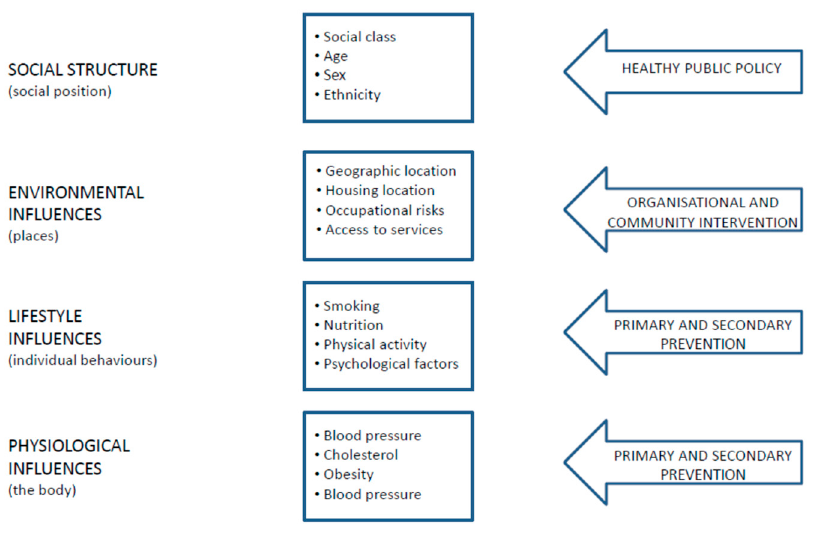
Figure 3. Levels of causation and corresponding types of intervention [26].